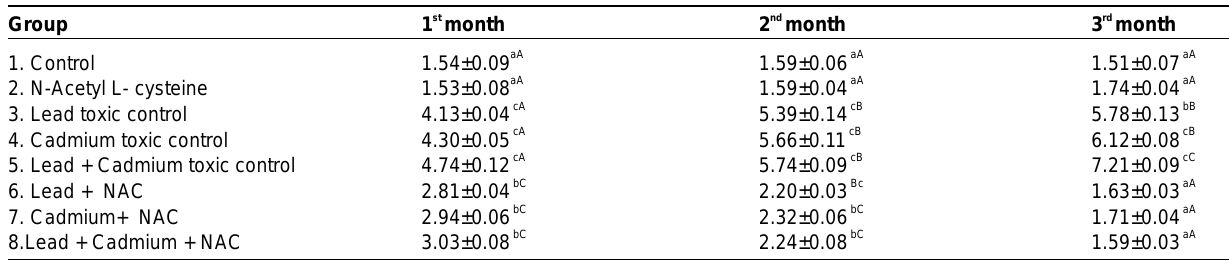
Table-1. Concentrations of serum creatinine in different groups of rats